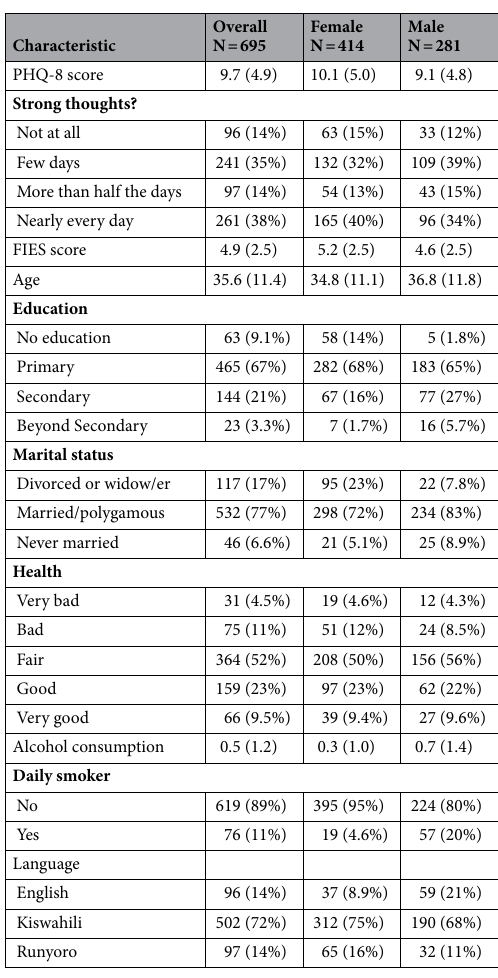
Table 3. Overall and gender-differentiated respondent characteristics. Numeric variables are described by their mean (and standard deviations). Categorical data are described by their counts (and percentages). Key: PHQ-8 = eight-item Patient Health Questionnaire, FIES = Food Insecurity Experience Scale, Alcohol consumption = how many days a week a respondent consumes